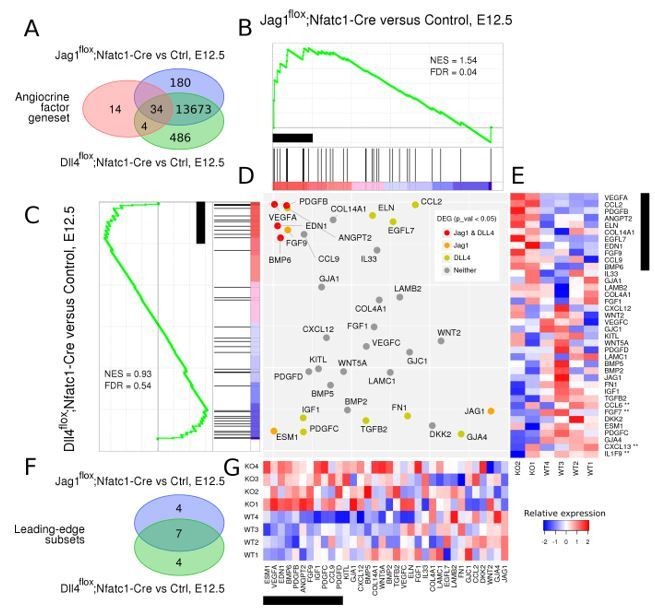
GSEA analysis of Jag1flox;Nfatc1Creand Dll4flox;Nfatc1Cre RNA-seq datasets compared against respective controls (Ctrl).Figure 2. GSEA analysis of Jag1flox;Nfatc1Cre and Dll4flox;Nfatc1Cre expression profiles, compared against their respective WT controls. An angiocrine factor gene set consisting of 52 genes was obtained from a previous publication (see Author response table 1 and Nolan et al. Dev Cell. 2013 Jul 29; 26(2)). Of the 52 angiocrine factors, 38 were detected as expressed in the Dll4 contrast (14,302 genes), and 34 in the Jag1 contrast (13,982 genes), as represented by the Venn diagrams at the upper left corner (panel A). GSEA results indicated that angiocrine factors were enriched among the genes that are more expressed in both Jag1 and Dll4 mutant backgrounds, as indicated by the respective enrichment profiles (panels B and C). In these profiles, red to blue gradient stripes represent the complete collections of expressed genes, sorted by decreasing fold change value in mutant versus WT contrasts: red colours indicate higher expression in mutant background (positive fold change), and blue colours indicate higher expression in WT background (negative fold change). Angiocrine factors, represented by black segments perpendiculary oriented along the gradient stripes, tend to concentrate in positive regions, as indicated by the green enrichment curves. Normalized enrichment score (NES) was therefore positive for both contrasts (1.54 and 0.93, for the Jag1 and Dll4 contrasts, respectively), although enrichment was statistically significant only for the Jag1 analysis (FDR = 0.04). Black rectangles indicate the groups of genes that contribute mostly to calculated NES values, which casually consisted in 11 genes for both analyses. The two leading edge subsets shared 7 genes (VEGFA, PDGFB, ANGPT2, EDN1, FGF9, CCL9 and BMP6), as represented by the Venn diagrams at the lower left corner (panel F). The central scatterplot (panel D) compares the fold change rank of the set of 34 angiocrine factors that were detected in both contrasts, and indicates (with a colour code) which of them were detected as differentially expressed (with p-value < 0.05) in each of the contrasts. Six leading edge subset angiocrine factors were detected as differentially expressed in at least one contrast, and four of them (VEGFA, BMP6, EDN1 and PDGFB) were detected in both. Heatmaps represent relative expression values for 38 angiocrine factors in Dll4 KO samples and their respective WT controls (panel E), and 34 angiocrine factors in Jag1 KO samples and the respective WT controls (panel G). Red and blue colours represent expression values above and below average, respectively. The four genes with asterisks in panel E are those that were detected as expressed only in the DLL4 contrast.